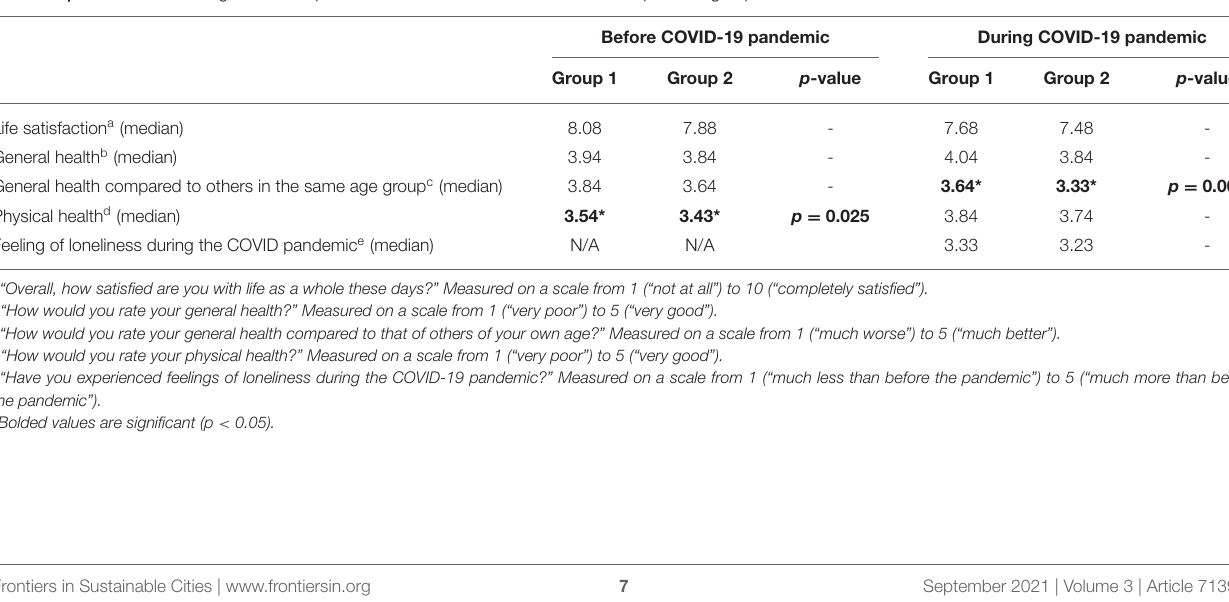
TABLE 3 | Differences in changes of self-reported health variables between the two respondent